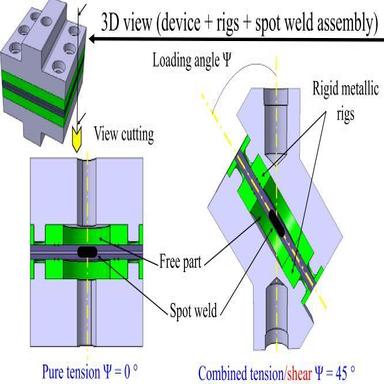
The proposed device with the studied specimen "three-sheet spot welded assembly + two rigid metallic rigs".